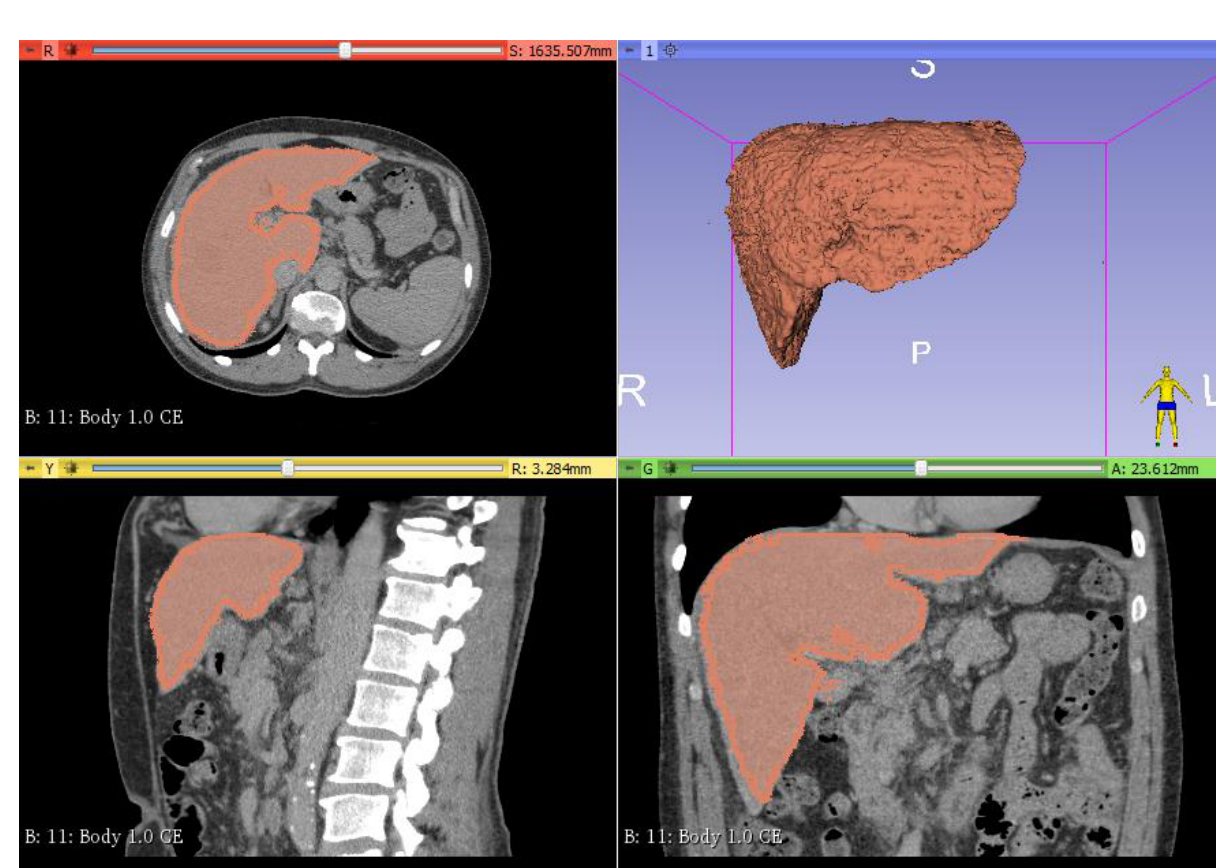
Figure A4: Three plan of segmentation in 3D